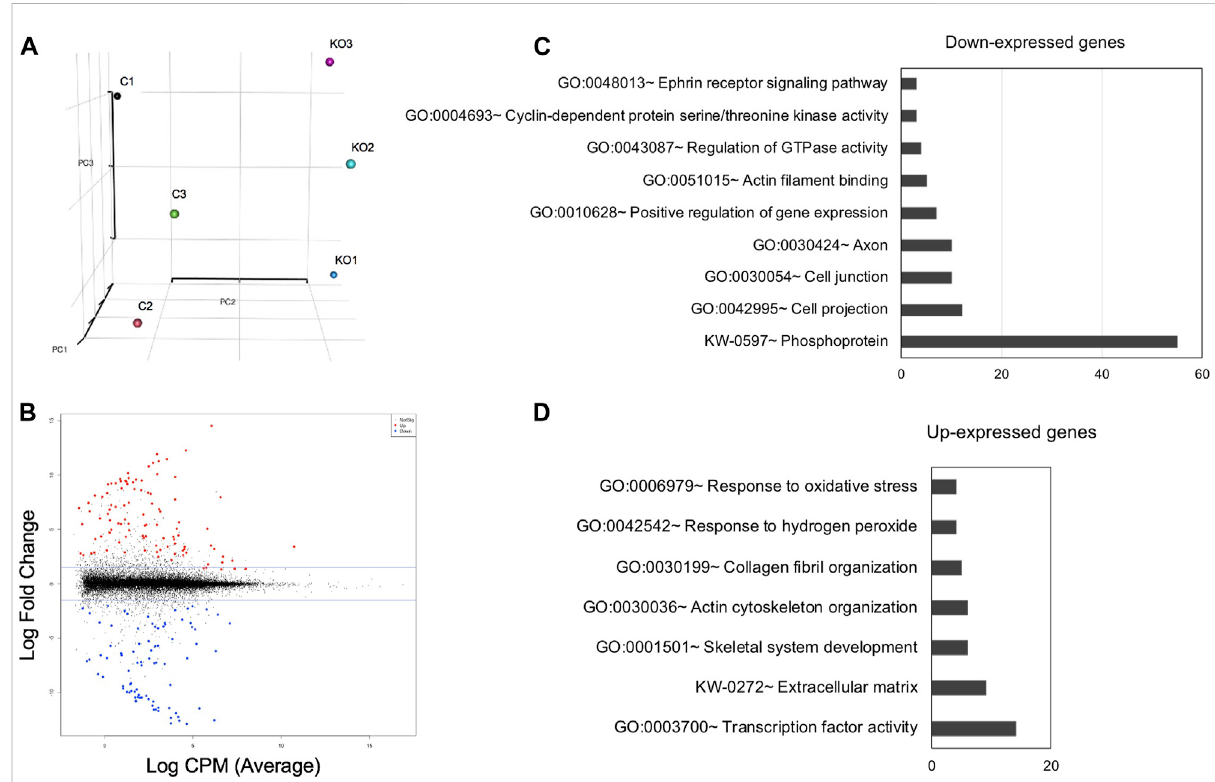
FIGURE 5 High-throughput RNA-sequencing analysis identi fi es genes misexpressed in Mafg − / − : Mafk − / − lenses. (A) Principal Component Analysis (PCA) shows that the RNA-sequencing (RNA-seq) datasets representing Mafg +/- : Mafk +/- (control) and Mafg − / − : Mafk − / − (double KO) lens cluster based on their genotypes. (B) Plot of differentially expressed genes (DEGs) in Mafg − / − : Mafk − / − lens compared to control. (C) Gene Ontology (GO) and